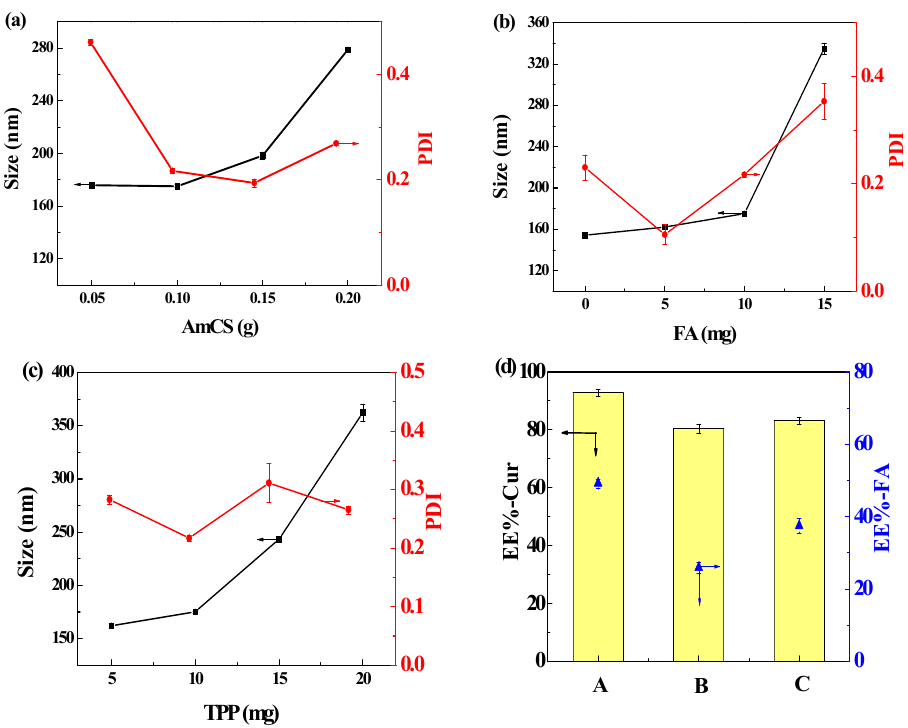
Figure 5. Effect of AmCS dosage ( a ), FA dosage ( b ), and TPP dosage ( c ) on the size and polydispersity index (PDI) of FA-AmCS-TPP nanoparticles. Effect of drug addition method ( d ) on the Cur encapsulation efficiency (EE-Cur, yellow bar graph) and FA encapsulation efficiency (EE-FA, ▲ , blue line graph) of Cur/FA-AmCS-TPP nanoparticles: (A) Cur added to the AmCS; (B) Cur added to the FA; (C) Cur added to the TPP.